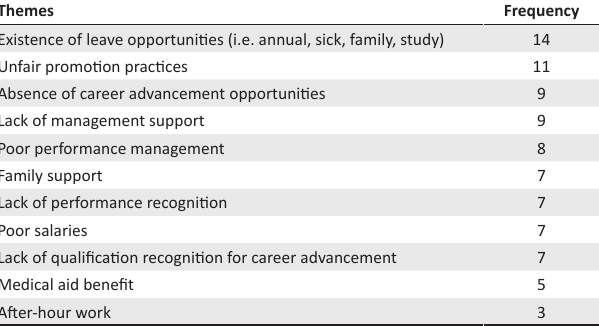
TABLE 2: Themes deduced from the interviews conducted with participants.